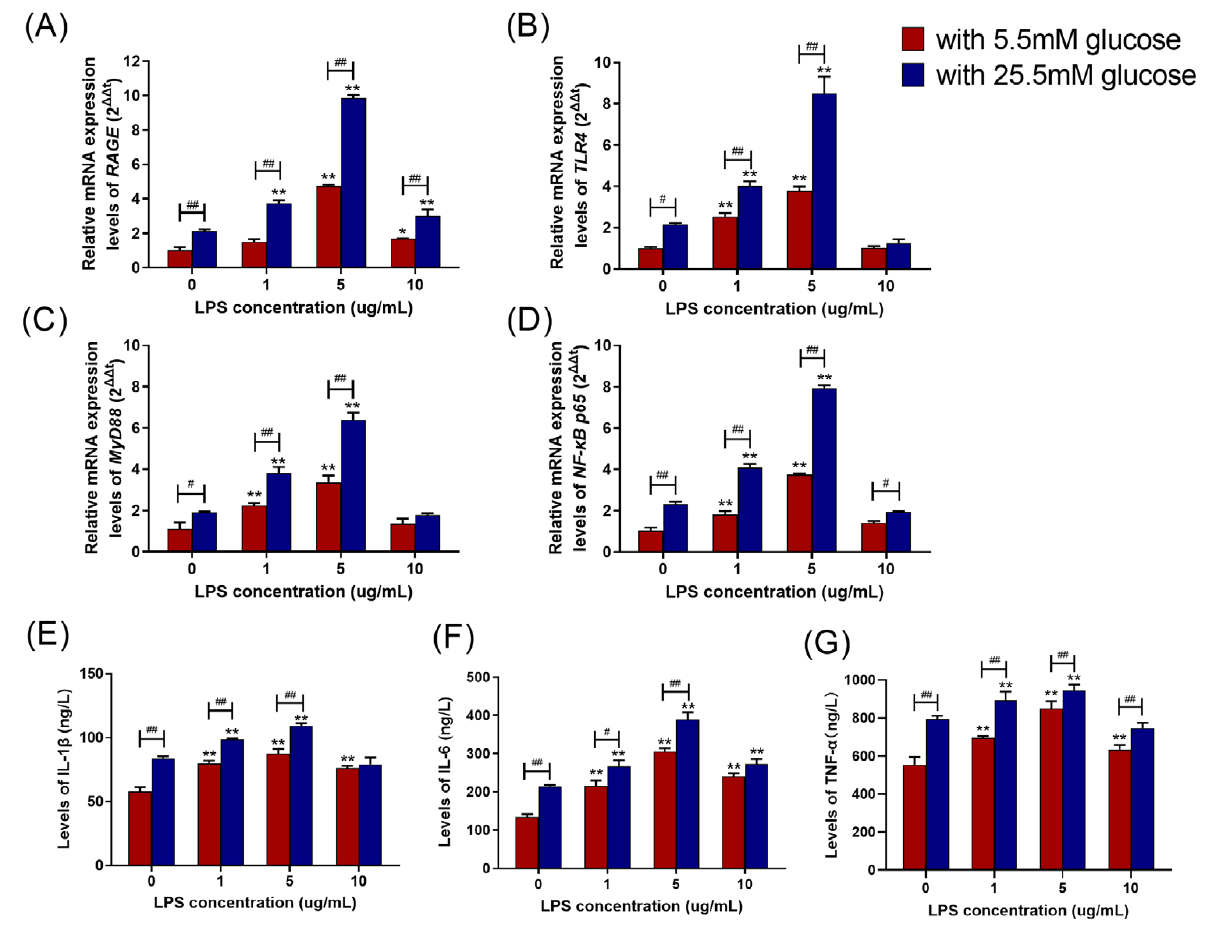
Figure 4. Effects of different glucose concentrations on LPS-induced pro-inflammatory cytokine secretion and the RAGE / TLR4 / MyD88 / NF- κ B p65 pathway in BAMs. ( A – D ) The impact of NG and HG on the levels of RAGE, TLR4, MyD88, and NF- κ B p65 mRNA expression in the presence of